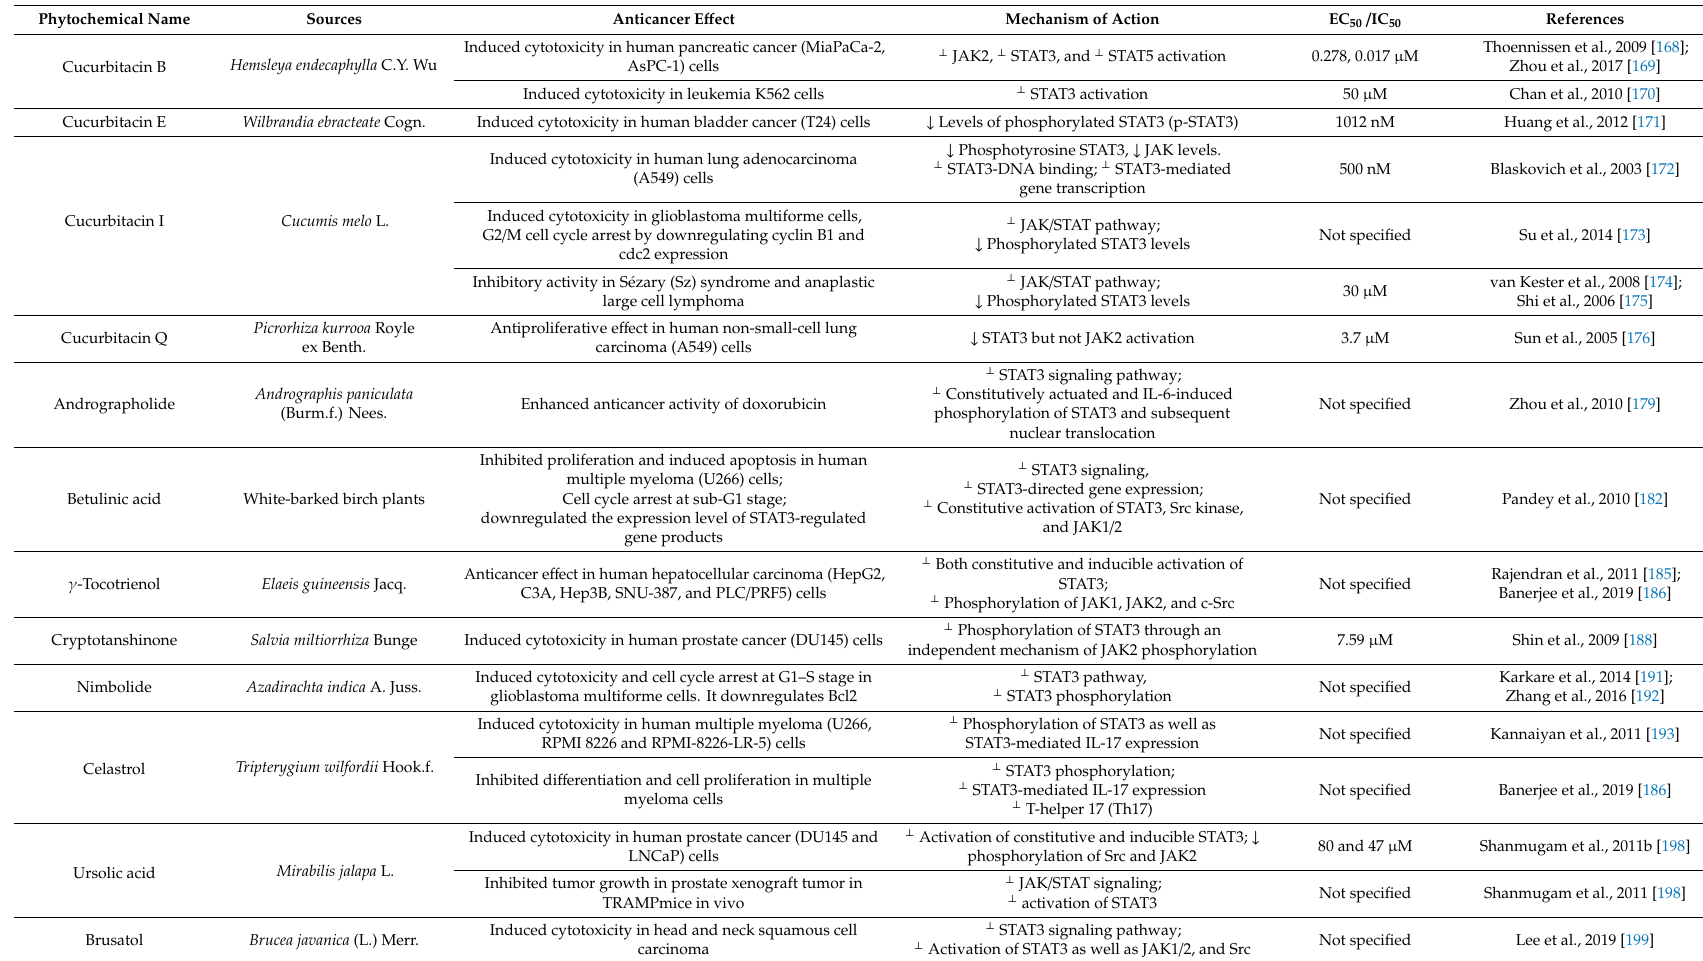
Table 2. Potential anticancer activities of terpenoids related to inhibition of the JAK / STAT signaling